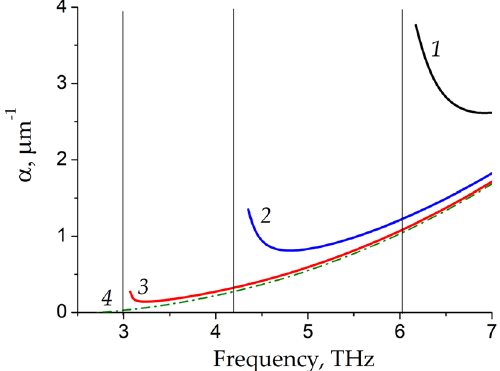
Figure 4. The power increment α in dependence on frequency for three different groove widths L = 0.5 μm, 1 μm, and 2 μm indicated by curves 1 , 2 , and 3 , respectively. The TM plasmon increment is shown by dash- dotted curve 4 . Vertical straight thin lines indicate the cut-off frequencies of the LSM